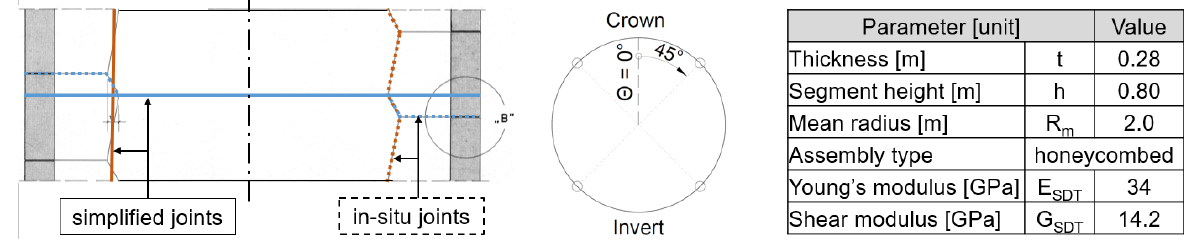
Fig. 5. Simplified geometry (left); SDT-parameters